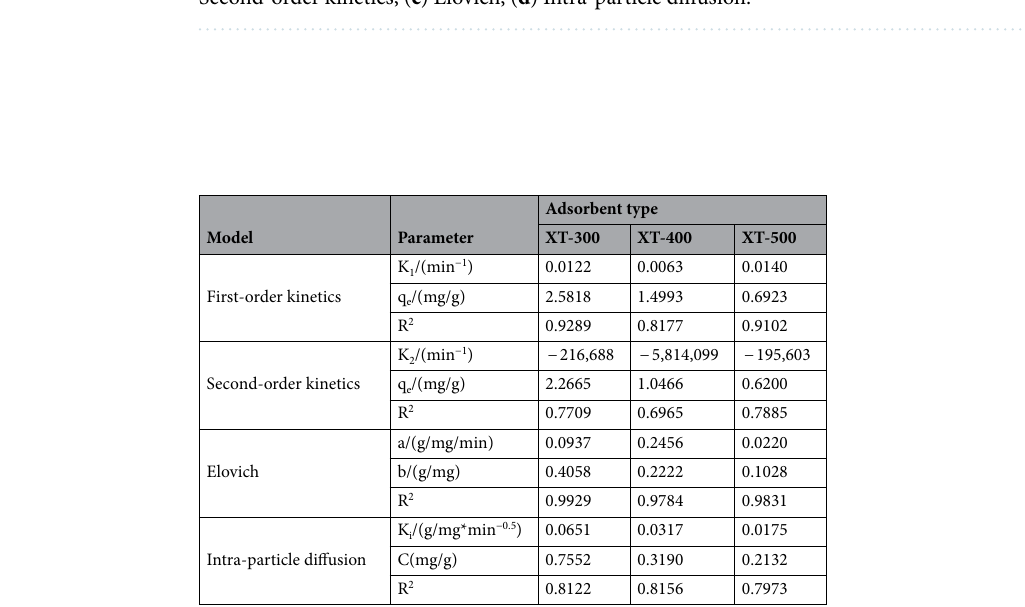
Figure 4. Adsorption kinetics of phosphate by adsorbents at different temperatures ( a ) First-order kinetics, ( b ) Second-order kinetics, ( c ) Elovich, ( d ) Intra-particle diffusion.